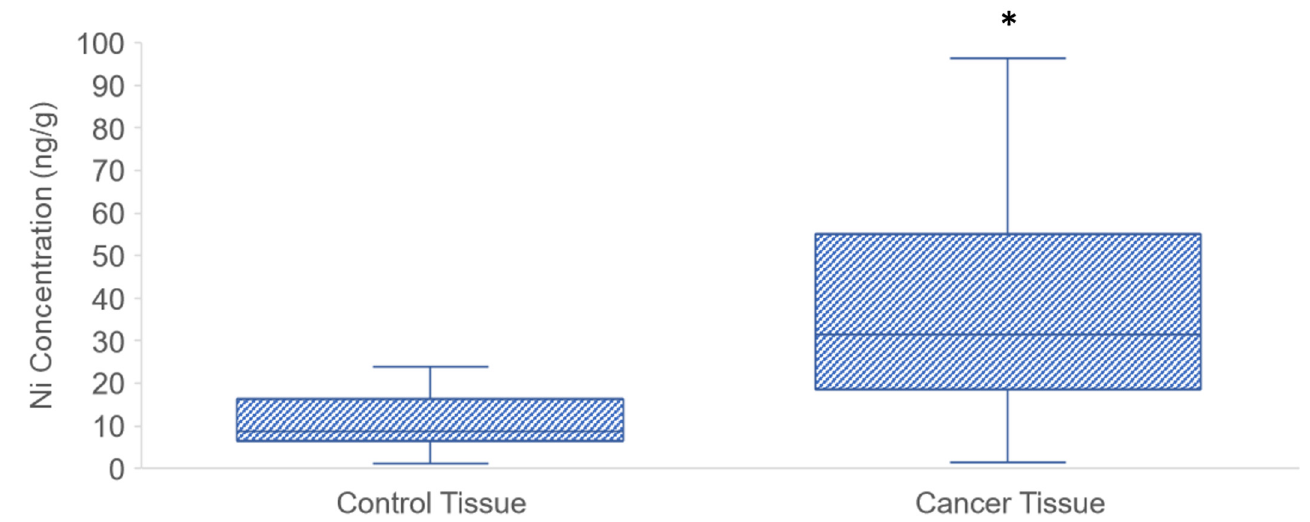
Figure 2. Levels of Ni in human pancreatic tissue in the investigated population. Boxes represent interquartile intervals (25–75%), while lines inside boxes represent medians. The box represents the interquartile range (25–75th percentile), the line within the box represents median value and ends of the whiskers represent the minimum and maximum values within the group. The asterisk indicates a statistically significant difference from the control levels (Mann–Whitney U test, p < 0.001).